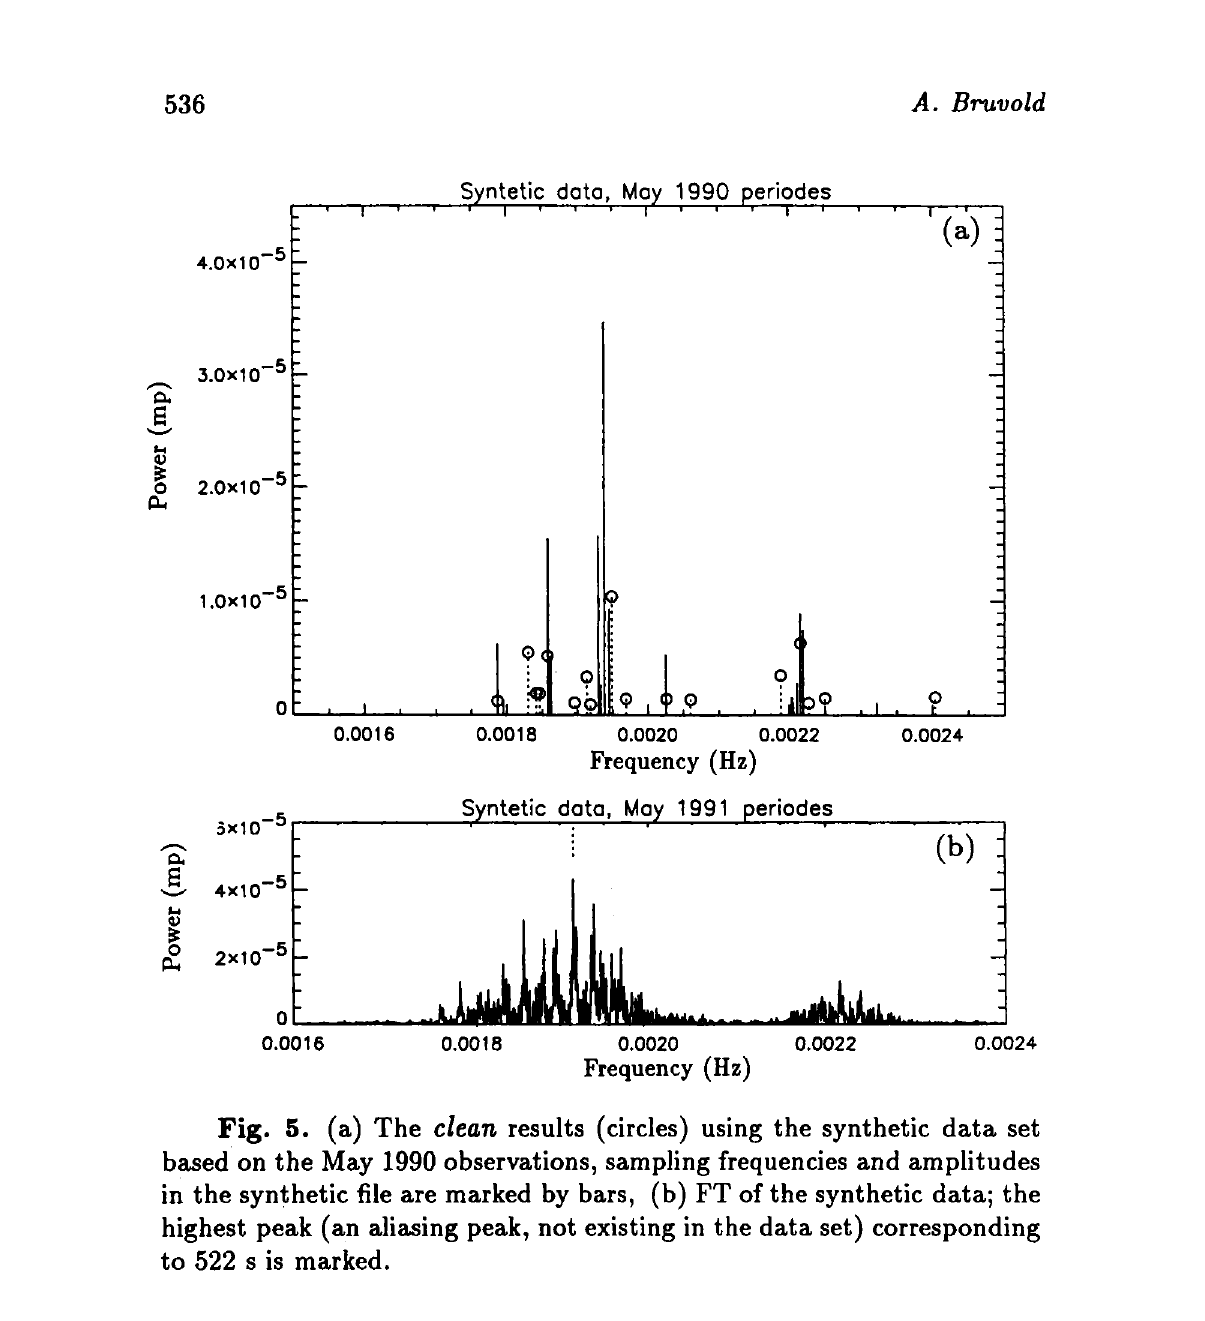
Fig. 5. (a) The clean results (circles) using the synthetic data set based on the May 1990 observations, sampling frequencies and amplitudes in the synthetic file are marked by bars, (b) FT of the synthetic data; the highest peak (an aliasing peak, not existing in the data set) corresponding to 522 s is